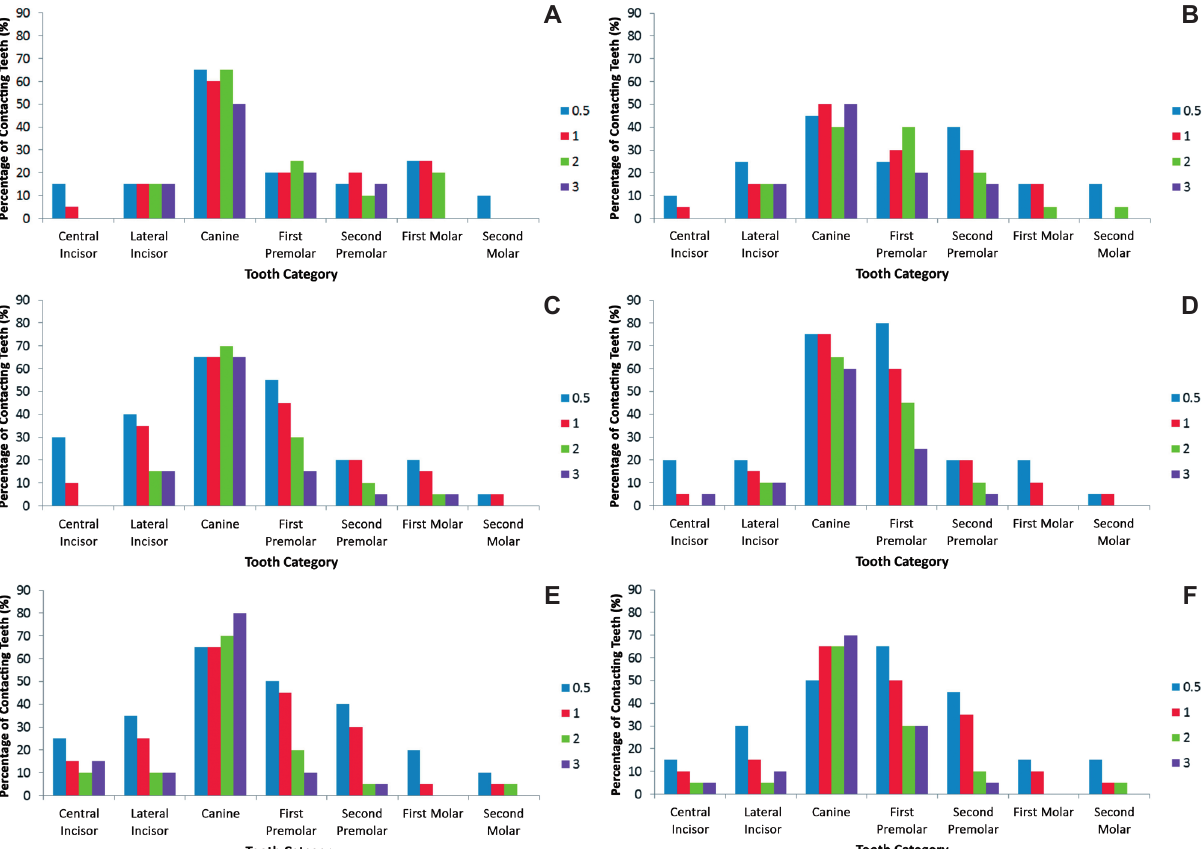
Figure 6- Percentage of the contacting teeth in each excursive position for all the models. (A) Pre-treatment maxillary arch; (B) Pre-treatment mandibular arch; (C) Conventional wax-up maxillary arch; (D) Conventional wax-up mandibular arch; (E) Digital wax-up maxillary arch; (F) Digital wax-up mandibular